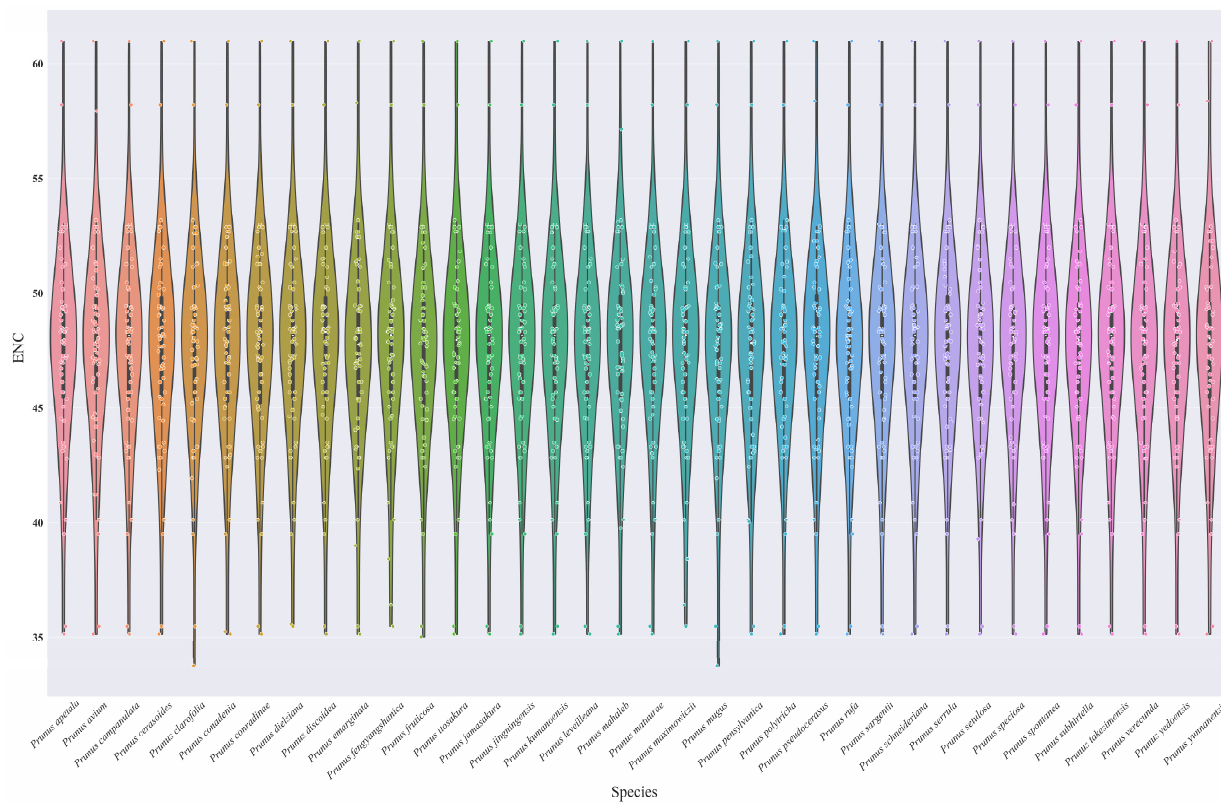
Figure 2. The ENC values of chloroplast genes in subg. Cerasus species. The x-axis represents 36 sub. Cerasus accessions, and the y-axis indicates the ENC value for all CDS in each species. Table 1. Codon features of 36 subg. Cerasus chloroplast genomes.